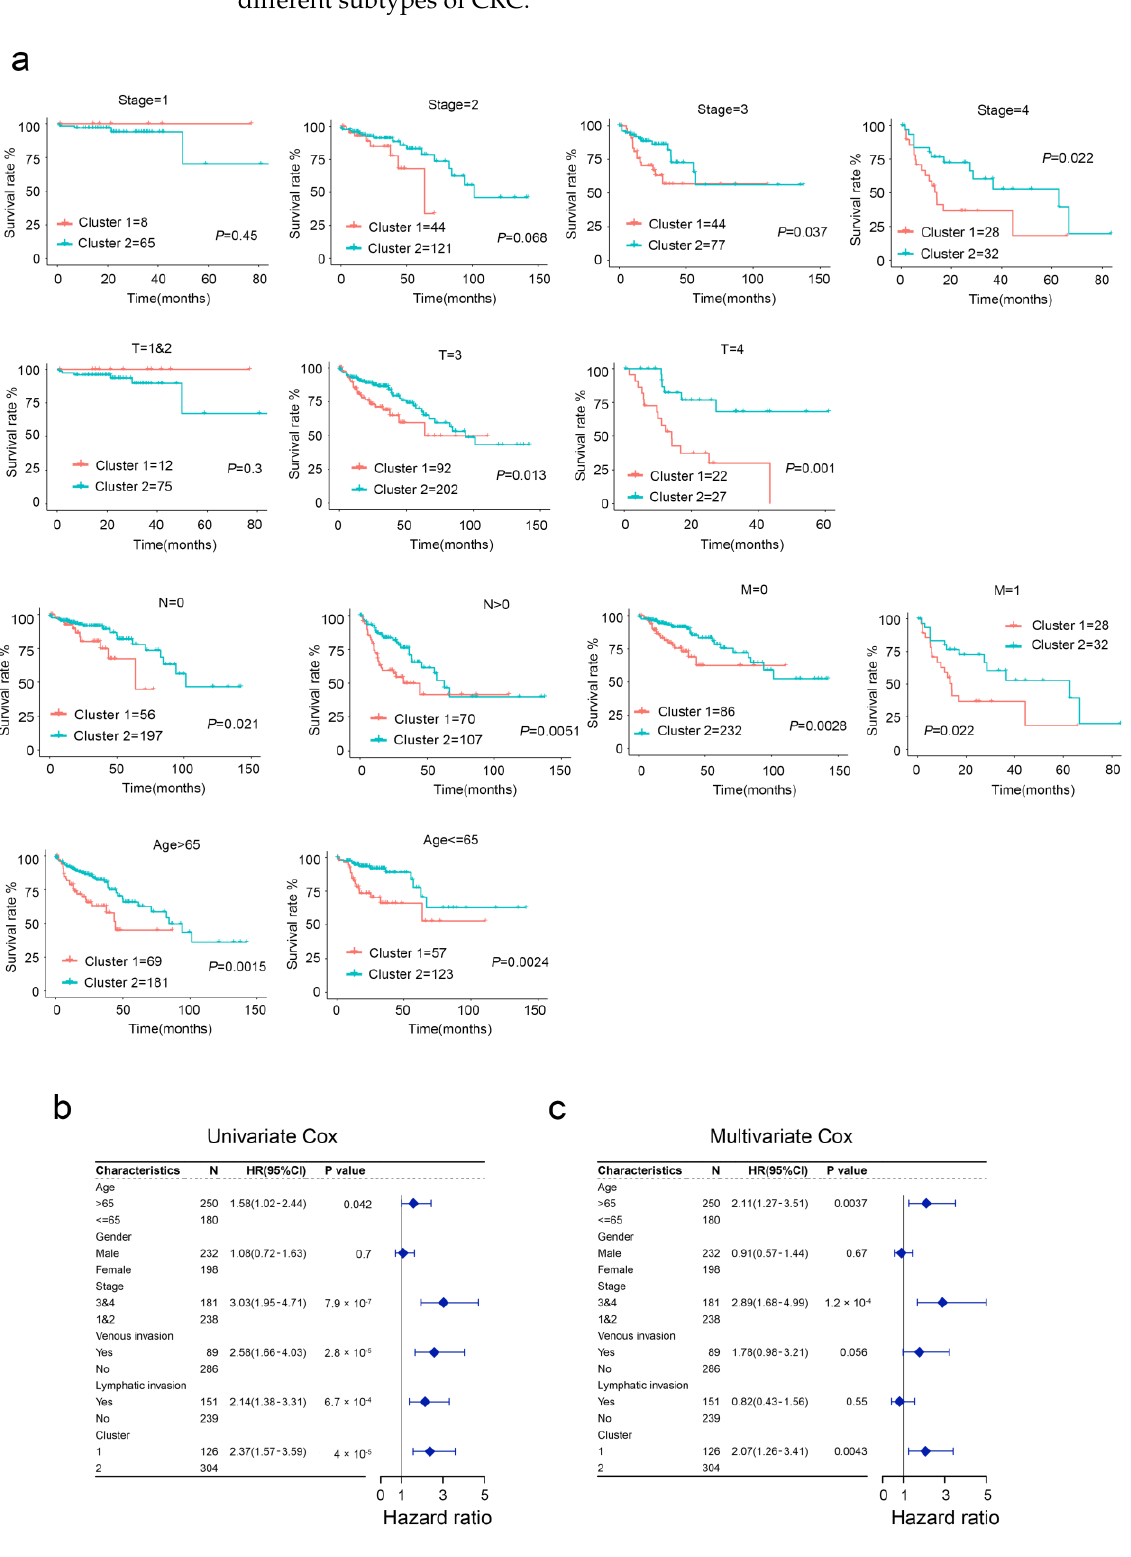
Figure 2. Clinical significance of aging subtypes in the TCGA cohort. ( a ) Survival curve analysis between different subtypes. ( b , c ) Univariate and multivariate Cox regression analyses of aging subtypes and other clinical factors.